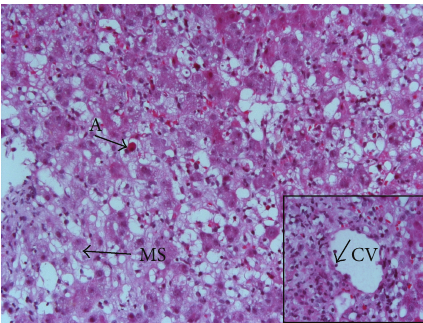
Figure 2: Histological view (haematoxylin-eosin stain, original magnification × 200) demonstrating extensive areas of hepatocytes with necrosis, ballooning degeneration, macro- and microvesicular steatosis (MS), and acidophil bodies (A). Insert: centrilobular vein (CV) showing endotheliitis (arrow) (original magnification × 400).